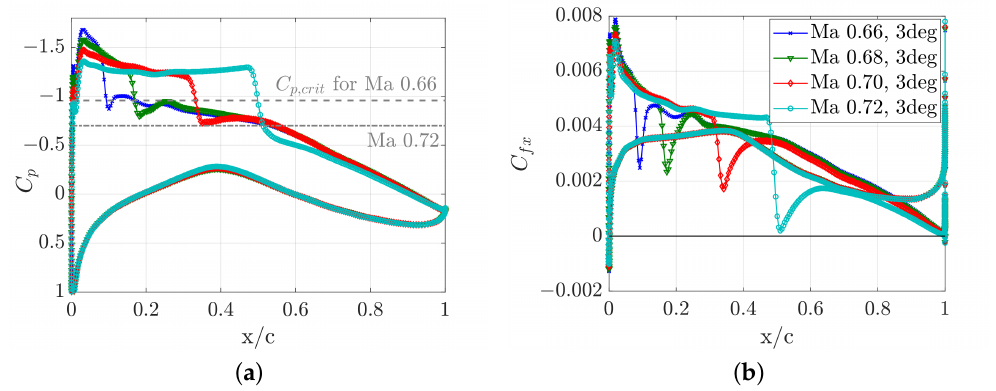
Figure 4. Local coefficients for different Mach numbers at 3 deg. ( a ) Pressure coefficients, ( b ) Skin friction